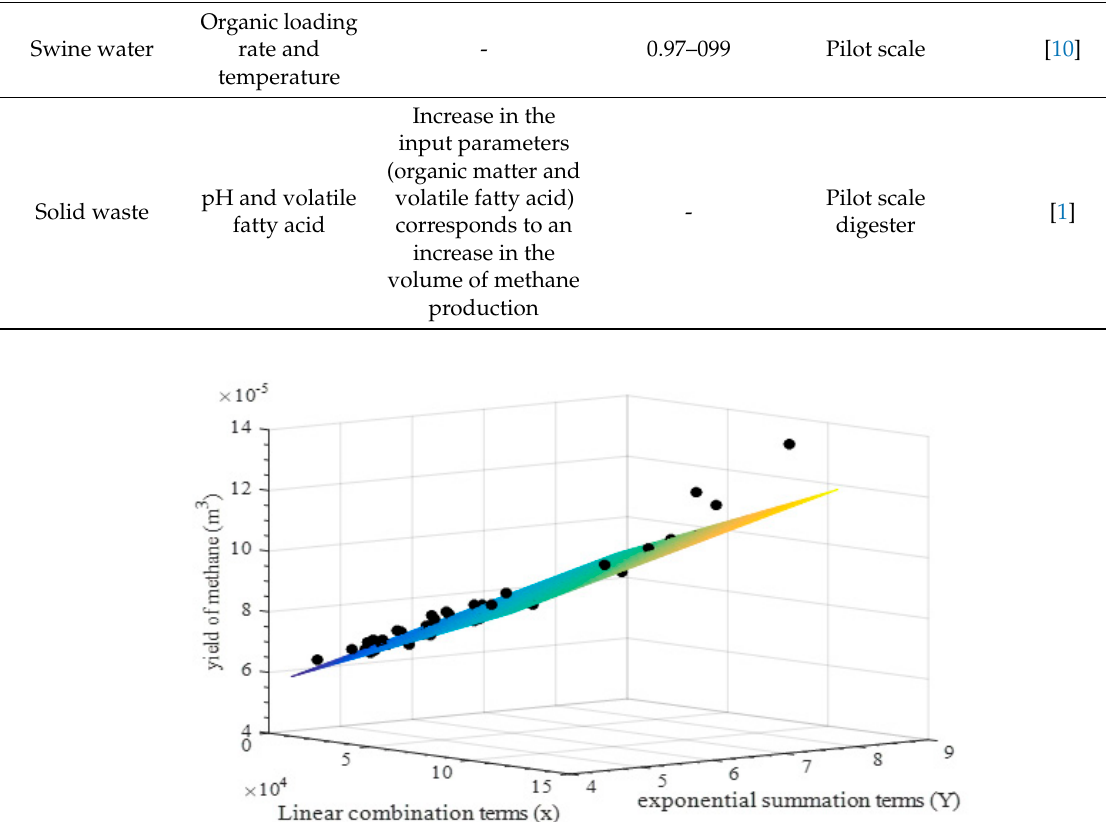
Figure 4. Model 3D mesh and calculated sample methane yield with inputs .